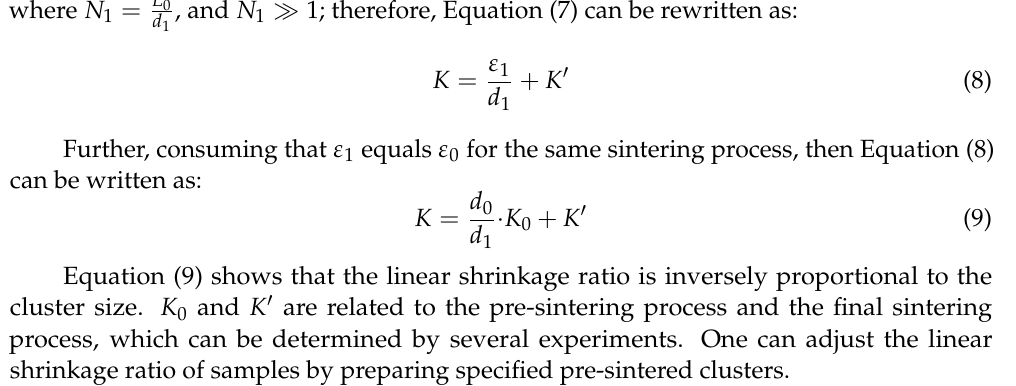
cluster size on the morphology and specific surface area were studied. The raw powders were, respectively, pre-sintered at 400 ◦ C, 500 ◦ C, 600 ◦ C, 700 ◦ C and 800 ◦ C for 60